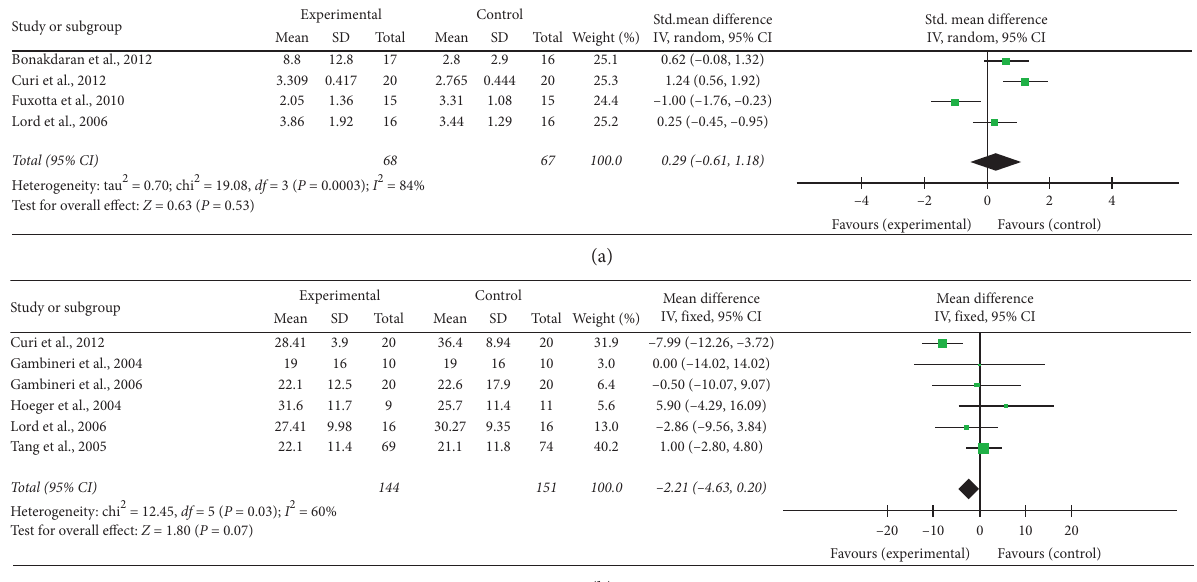
Std. mean difference IV, random, 95%